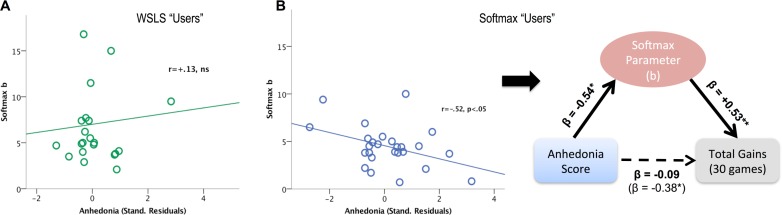
A. No significant correlation between Anhedonia and Softmax b parameter in WSLS “users”, r = +.13, ns. B. Left: Negative correlation between anhedonia and Softmax parameter in Softmax “users”, r = -.52, p < .05; Right: Mediation analysis with hierarchical linear regression models. Softmax b parameter was found to fully mediate the negative relationship between anhedonia and total points earned in the bandit task (among Softmax “users”, n = 29).